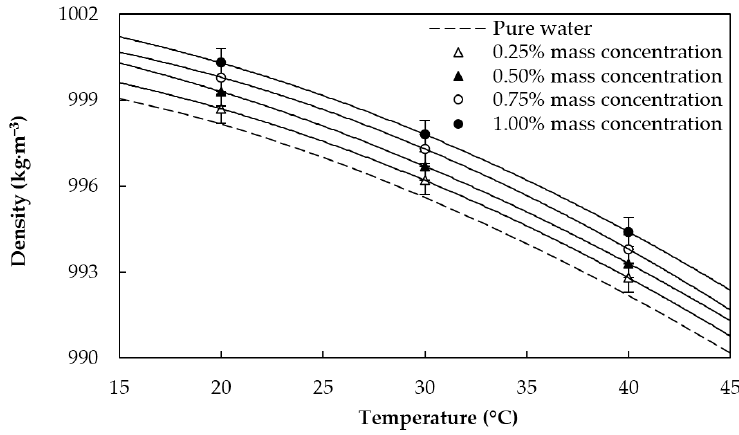
Figure 3. Density of the sulfonic acid-functionalized graphene nanoplatelet water-based nanofluids and water [37].